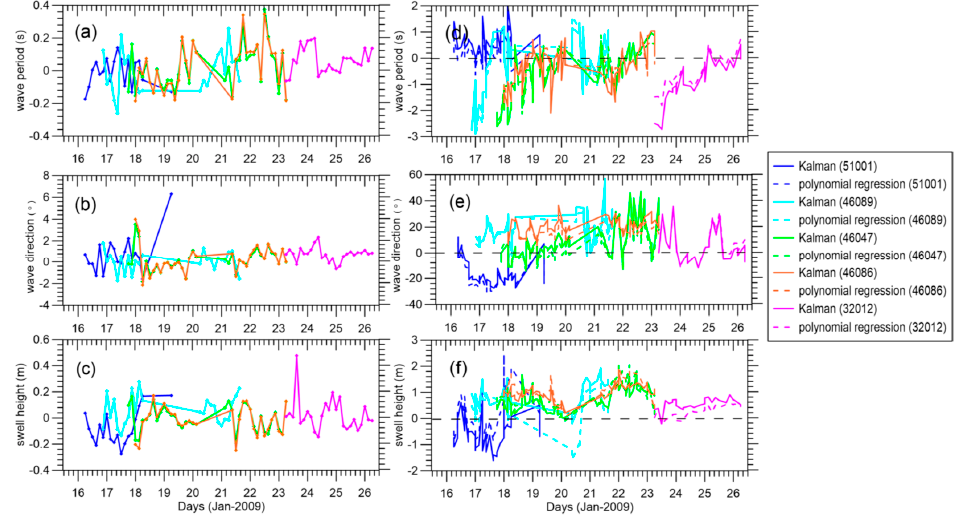
Figure 6. ( a – c ) The innovation of integral wave parameter and ( d – f ) the differences between the EnKF (solid line)/polynomial regression (dashed line) and buoy partitioned swells at buoys 51001, 46089, 46047, 46086, and 32012, respectively.